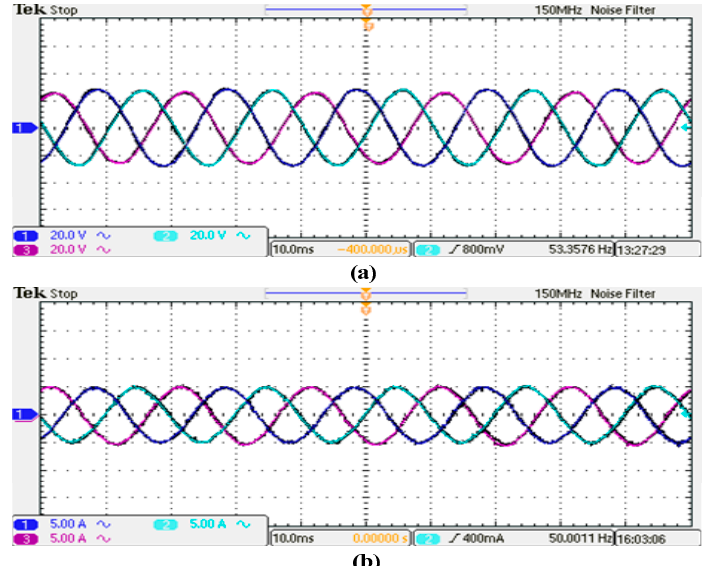
Figure 30. DFIG system in weak grid with high bandwidth improved PLL (a) Stator voltage, and (b) Stator current.